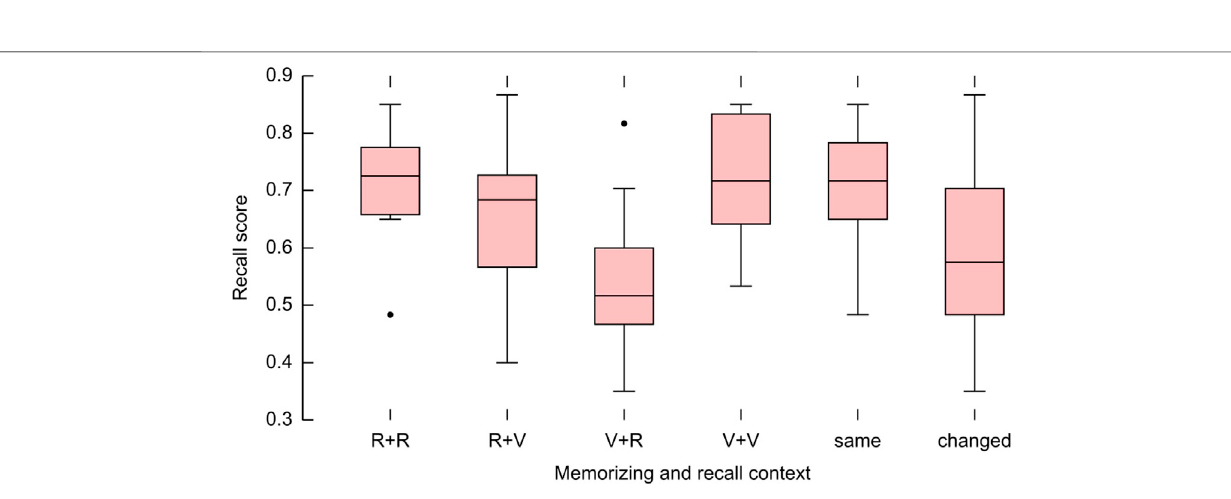
Frontiers in Virtual Reality |